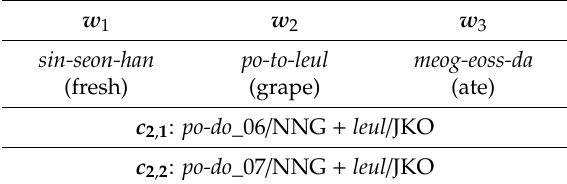
Table 4. An instance of WSD candidates of the e ojeol “ po-do